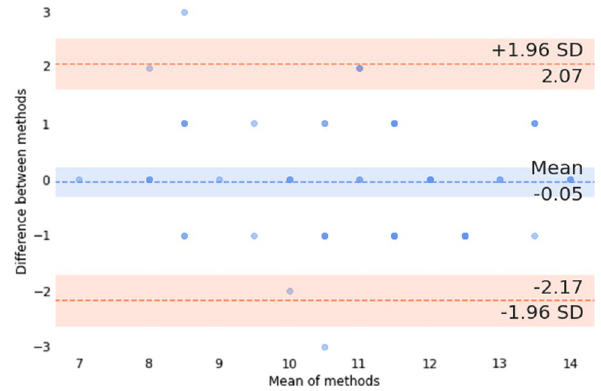
Fig. 8 Bland Altman difference plot for EC observations